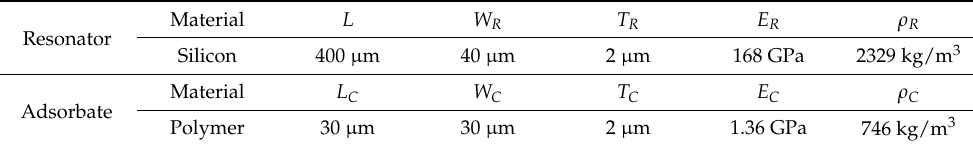
Table 1. The parameters of the silicon resonator and polymer